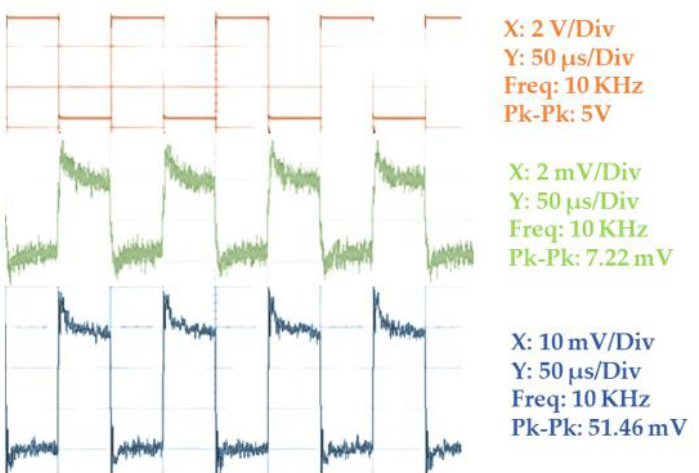
Figure 5. Output waveform from an individual GDD in the row detector circuit before amplification, and after amplification.